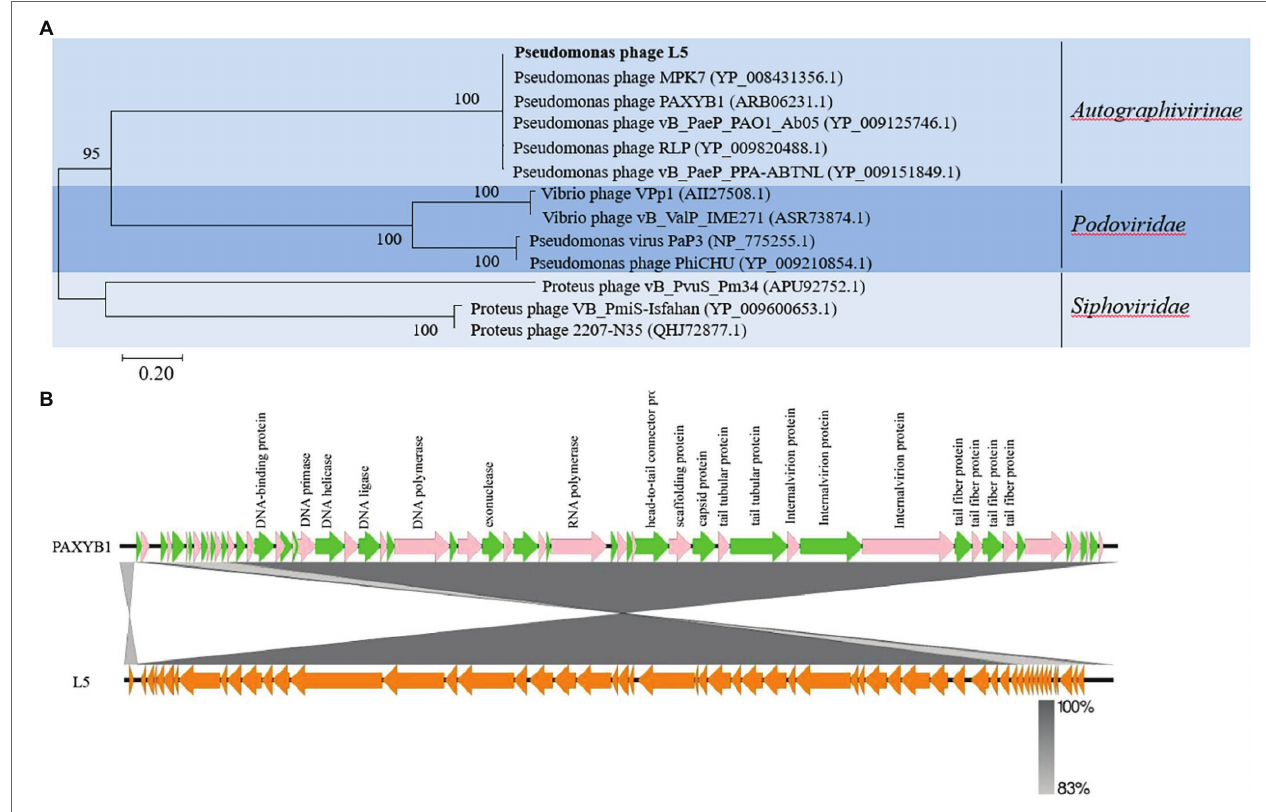
FIGURE 3 | (A) Phylogenetic analysis of P. aeruginosa phage L5 and related phages. The terminase large subunits of selected phages were compared using the ClustalW program, and the phylogenetic tree was generated using the neighbor-joining method with 1,000 bootstrap replicates. (B) Comparison of the genome sequence of phage PAXYB1(top) with L5 (bottom). Predicted ORFs and the direction of transcription are indicated by block arrows. Conserved regions are shaded in gray. The color intensity corresponds to the sequence identity level (83 to 100%). Genomic comparisons were performed using BLASTn. Similarities with E values lower than 0.00001 are plotted. The figure was produced using Easyfig 2.2.5 (Sullivan et al.,